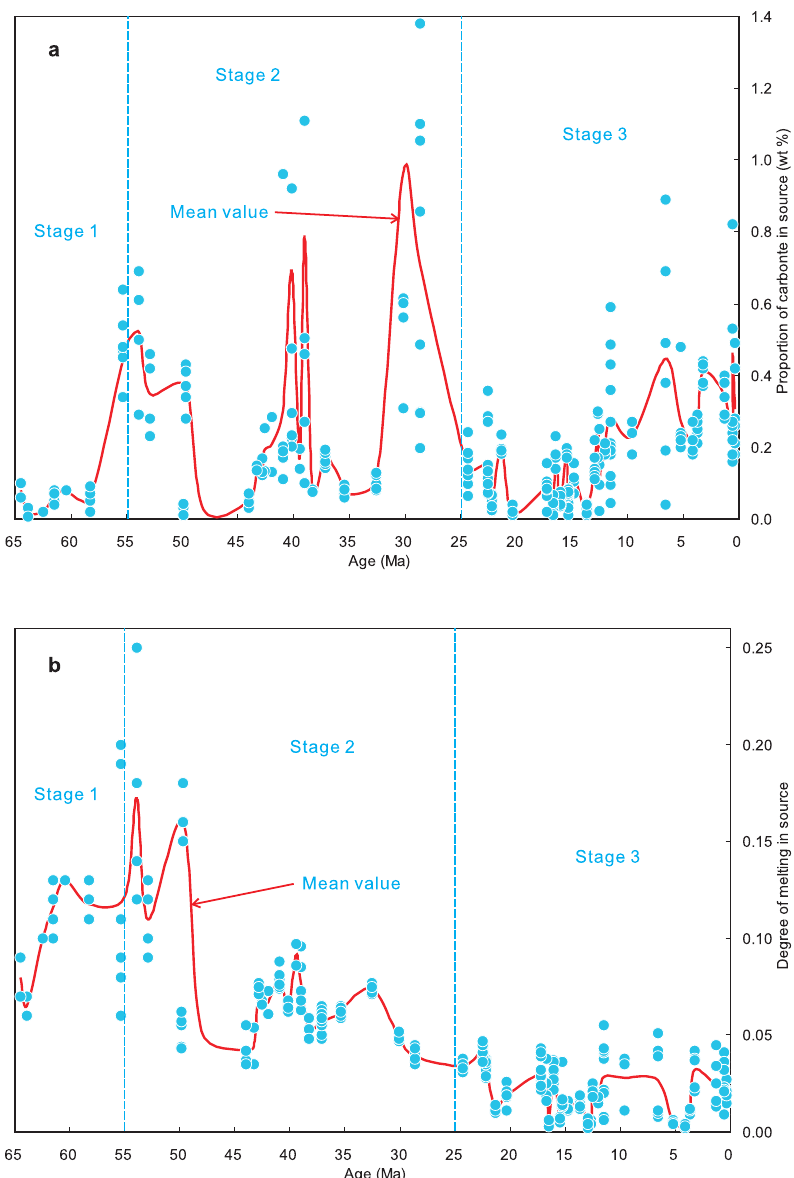
Fig. 3 Three-stage evolution of carbonate contents and melting degrees. Each fi lled blue dot denotes a calculation result of the carbonate content in ( a ) and melting degree in ( b ) by CCFM based on a set of geochemical data (including major element, trace element and Sr – Nd – Pb isotope composition) of each sample from 287 samples (for detailed calculation procedures see Supplementary Data 2 and “ Methods ” ), which have been distributed in 55 volcanic fi elds in Tibetan Plateau in the Cenozoic (Fig. 1). The mean value of the modelling results of these geochemical parameters in ( a ) and ( b ) in each volcanic fi eld is shown as a solid red curve (for detailed calculation results of the mean values see Table